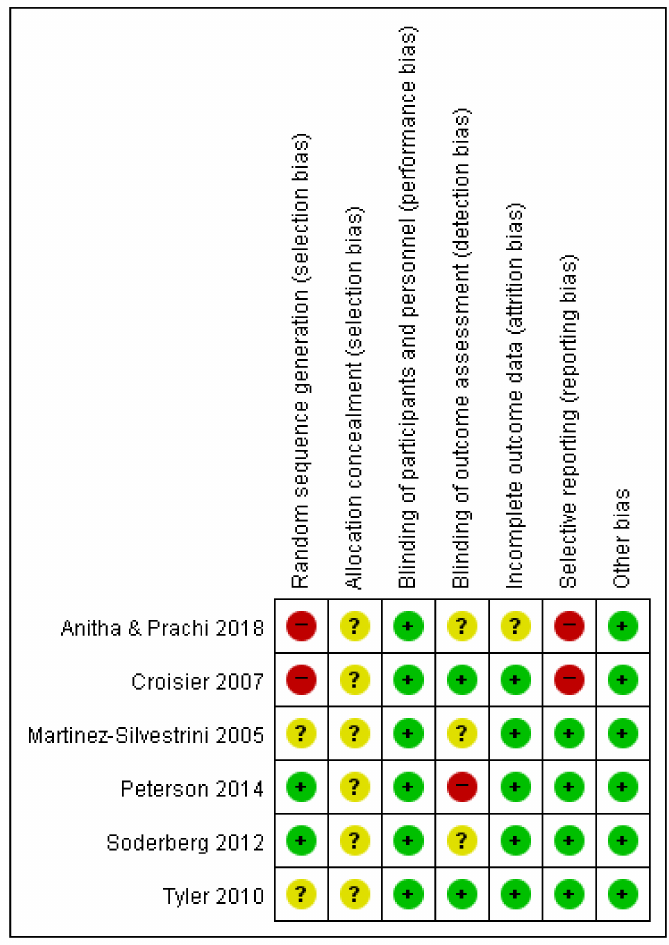
Figure 2. Risk of bias